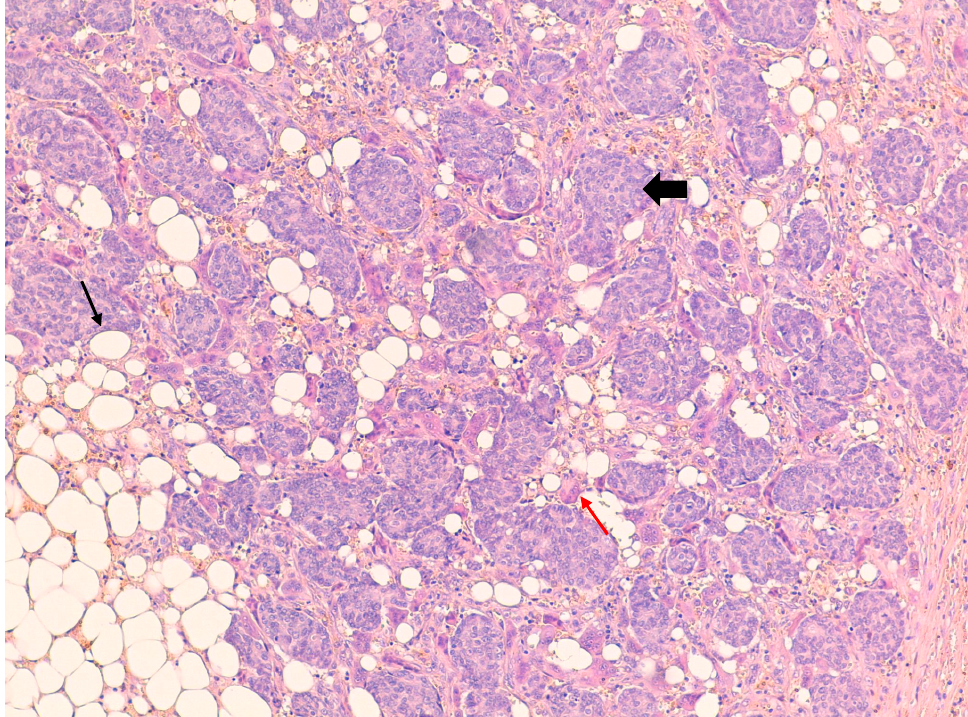
Figure 2. Hematoxylin and eosin stain 20x showing invasive ductal carcinoma with at least 30 osteoclast-like giant cells ( ↑ ), which are multinucleated cells and vary in shape and size with eosinophilic cytoplasm; grouped neoplastic cells ( ) are present immersed in the stroma containing adipocytes ( ↑ ).